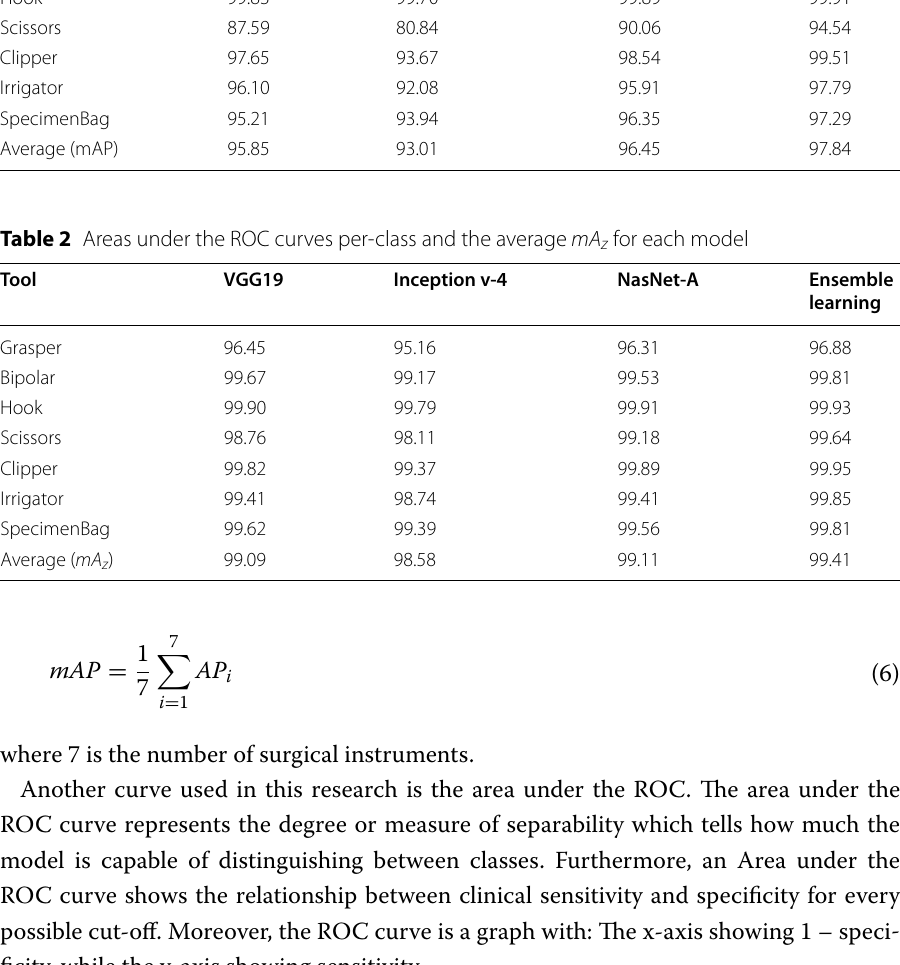
Table 1 Frame-level presence detection average precision (AP) per-class and mean average precision (mAP) for each model Tool